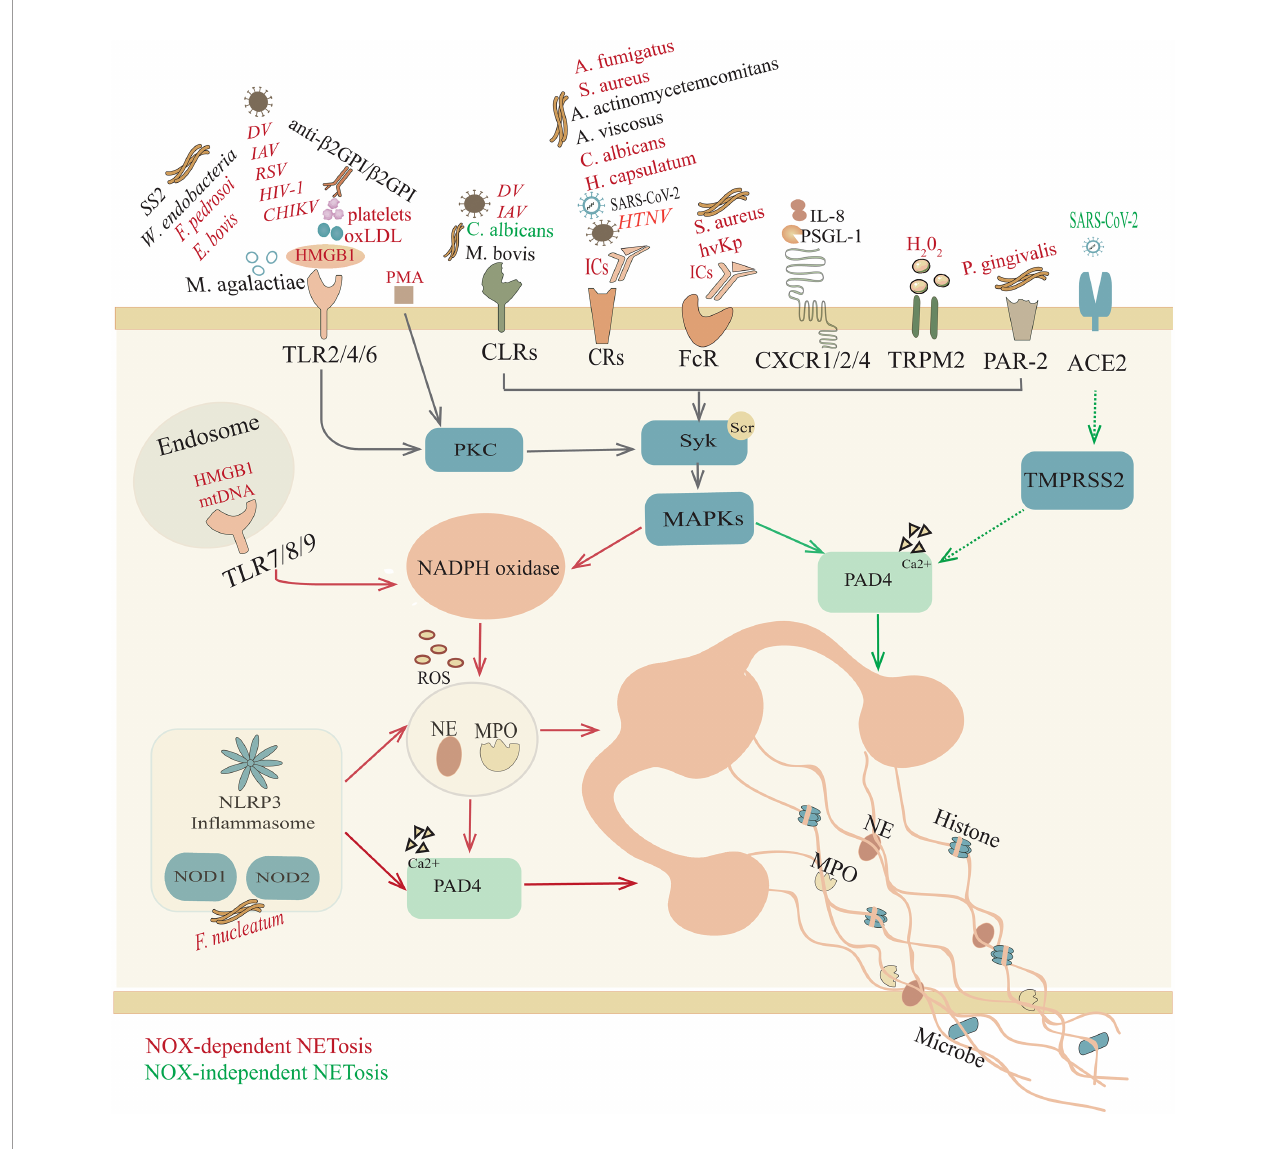
FIGURE 1 | Overview of NETosis. Trigger factors, such as pathogenic microorganisms, ICs, HMGB1, oxLDL, H 2 O 2 , and mtDNA, induce NOX-NETosis. In response to different stimuli, neutrophils participate in a response through their surface receptors, including Toll-like receptors (TLRs); C-type lectin receptors (CLRs); complement receptors (CRs); Fc receptors (FcRs); chemokine receptors (CXCRs); NOD-like receptors (NOD1/2); transient receptor potential melastatin 2 (TRPM2); and protease activated receptor-2 (PAR-2), initiating p38 mitogen-activated protein kinase (MAPK) signaling and producing ROS, which activate MPO, NE and PAD4. Afterward, activated NE and MPO are transferred to the nucleus to promote further unfolding of chromatin, thereby destroying the nuclear membrane. However, in the NOX- independent NETosis pathway, unopsonized C. albicans yeast interacts with CLRs (Dectin 2) and SARS-CoV-2 bonds with angiotensin converting enzyme 2 (ACE2) and transmembrane protease serine 2 (TMPRSS2) to activate PAD4, which can lead to histone citrullination and participate in chromatin decondensation. Subsequently, chromatin is released into the cytoplasm, where it is decorated with granules and cytoplasmic proteins. However, for some other microorganisms ( M. agalatiae, SS2, M. bovis, A. actinomycetemcomitans, A. viscosus, SARS-CoV-2) , IL-8, PSGL-1 and anti- b 2GPI/ b 2GPI, it is still unclear whether the speci fi c mechanism of NET formation requires